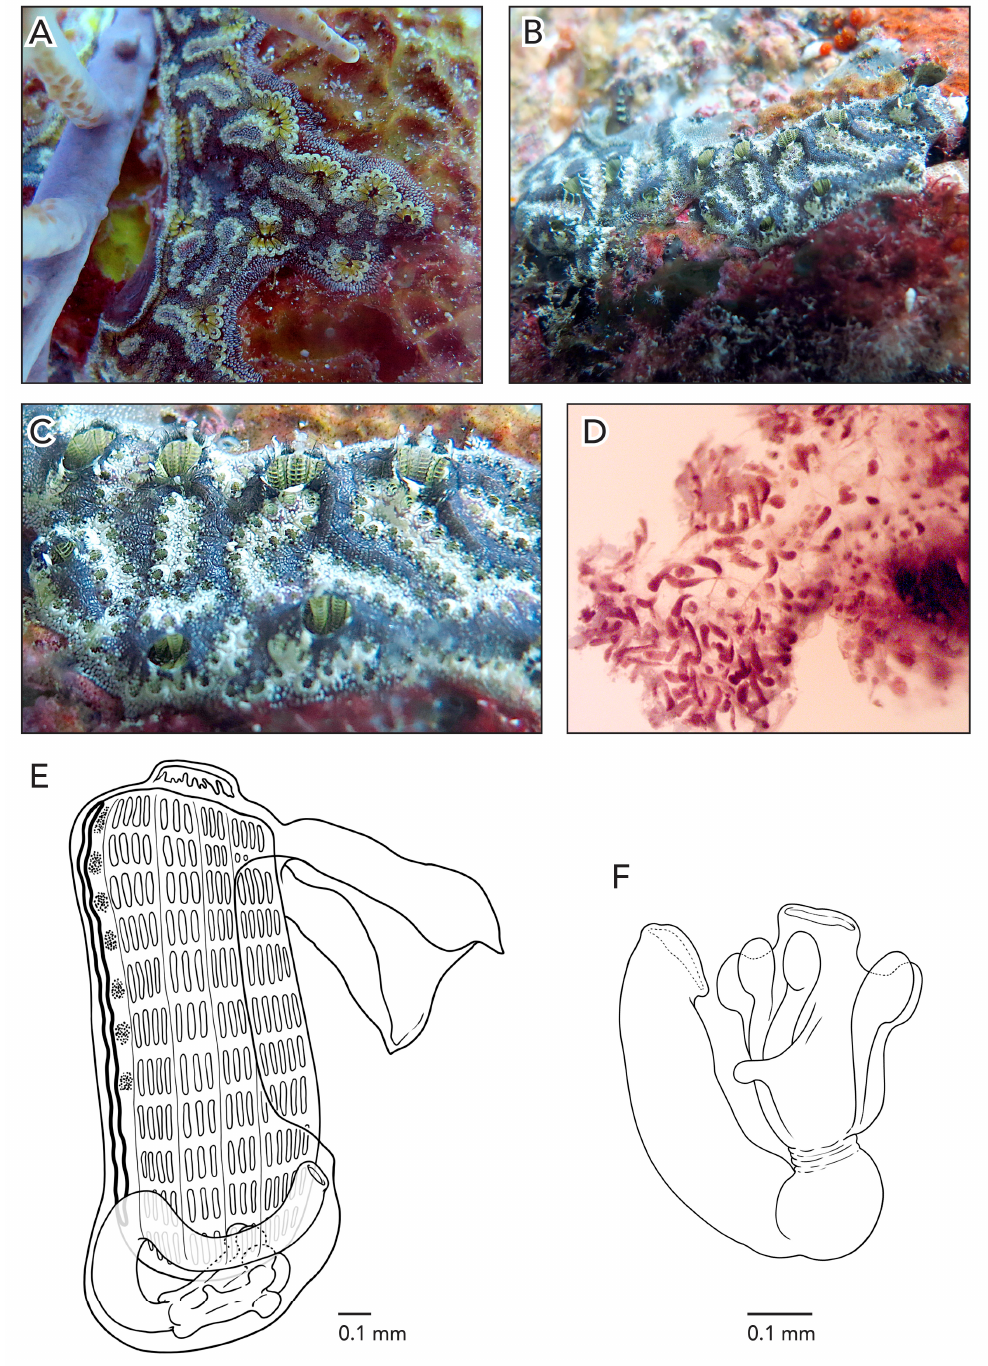
Figure 13. Botrylloides catalitinae sp. nov. ( A – C ) Live colonies on natural substrate (Sponge) ( D ) Detail of one preserved colony showing the vascular system with ampullae ( E ) Left side view of a zooid ( F ) Detail of the abdomen